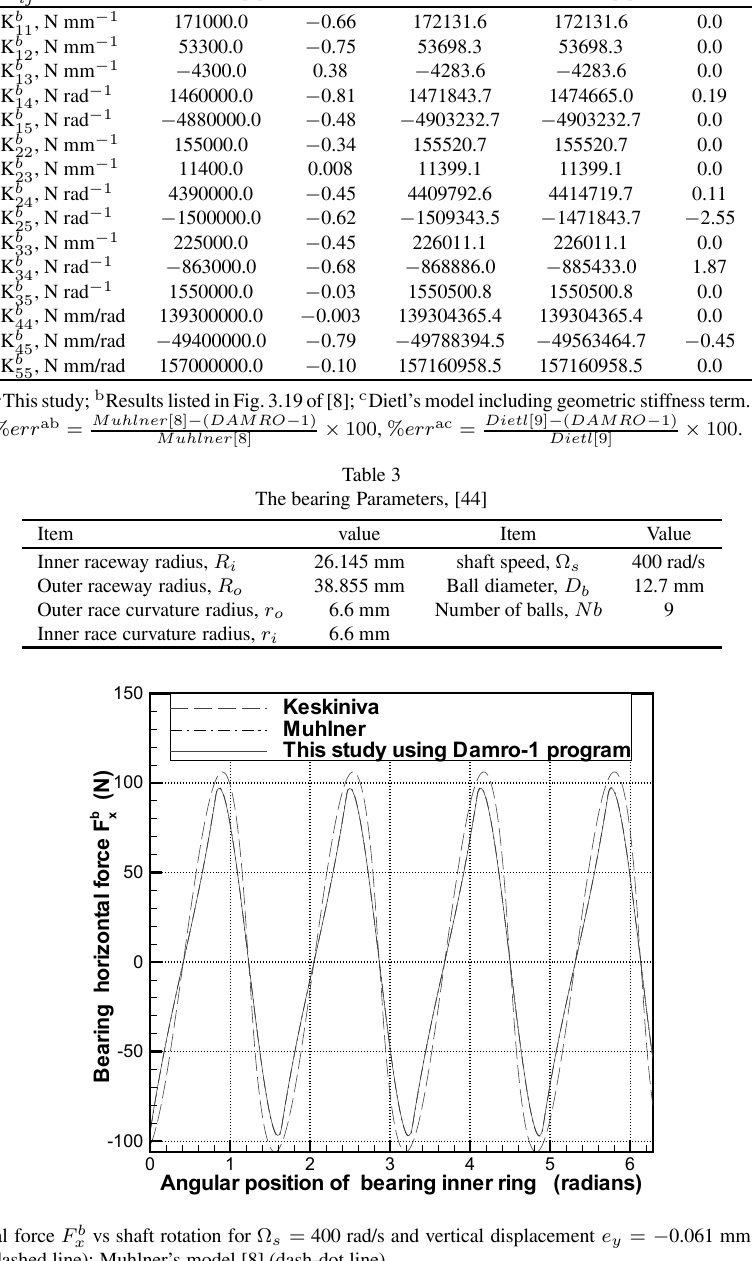
ACBB 7039 Stiffness matrix coef fi cients, K b